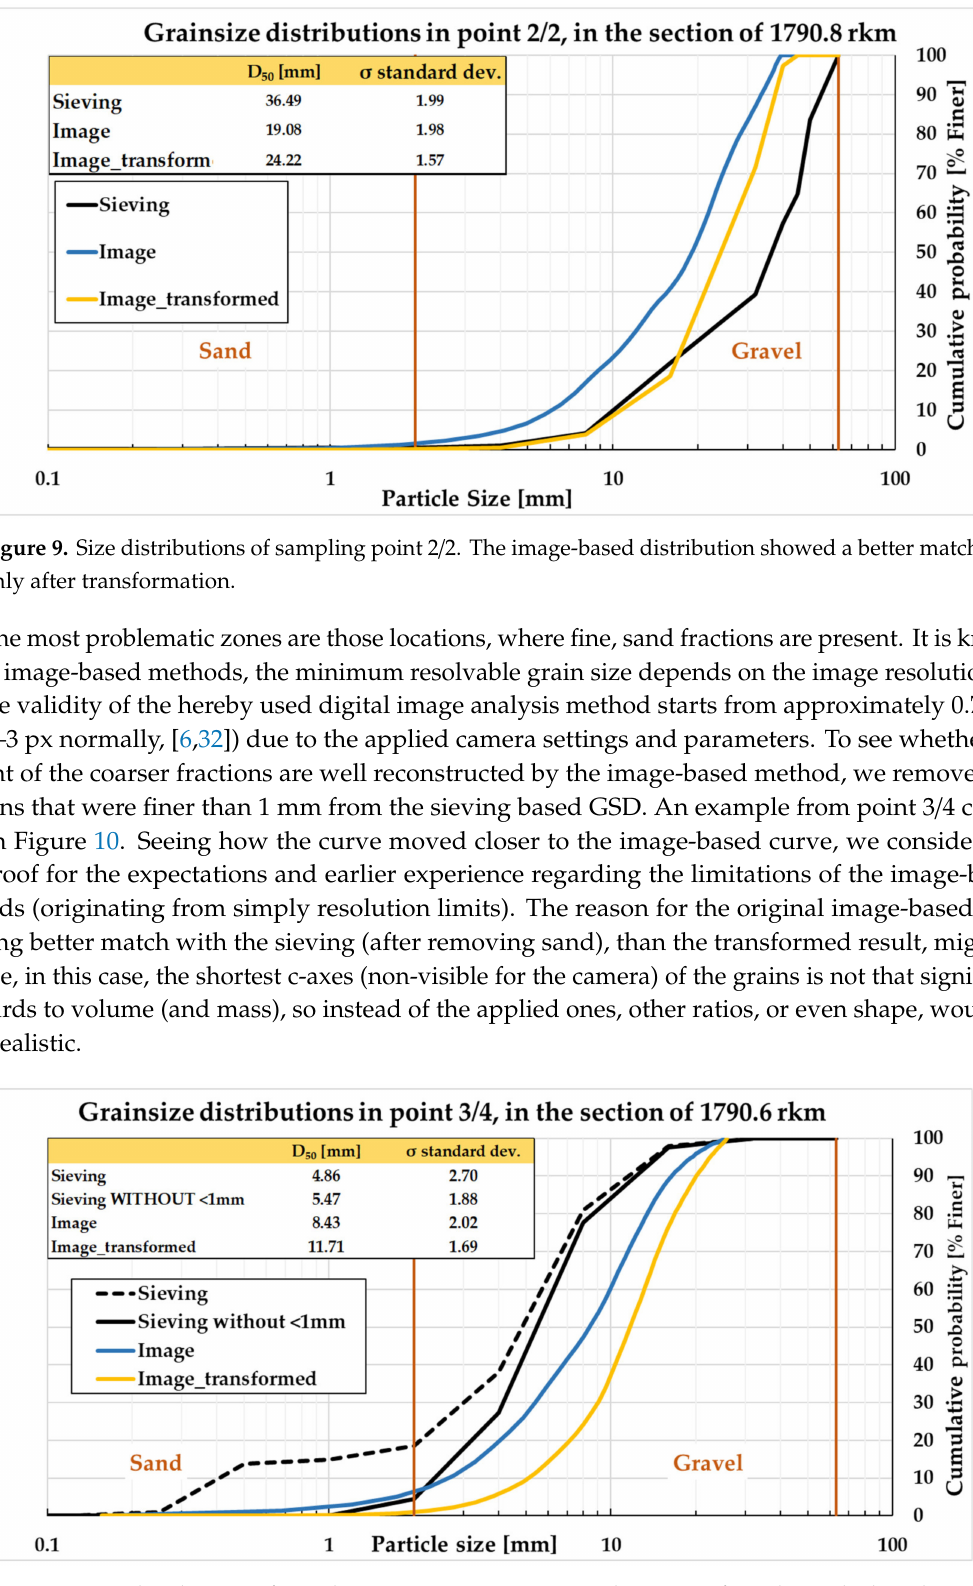
Figure 10. Size distributions of sampling point 3 / 4. Due to sensing limitations from the applied resolution, both the original and transformed image-based distributions were not matching. By removing the finer than 1 mm fractions from the sieve, the filtered curved got closer to the image-based